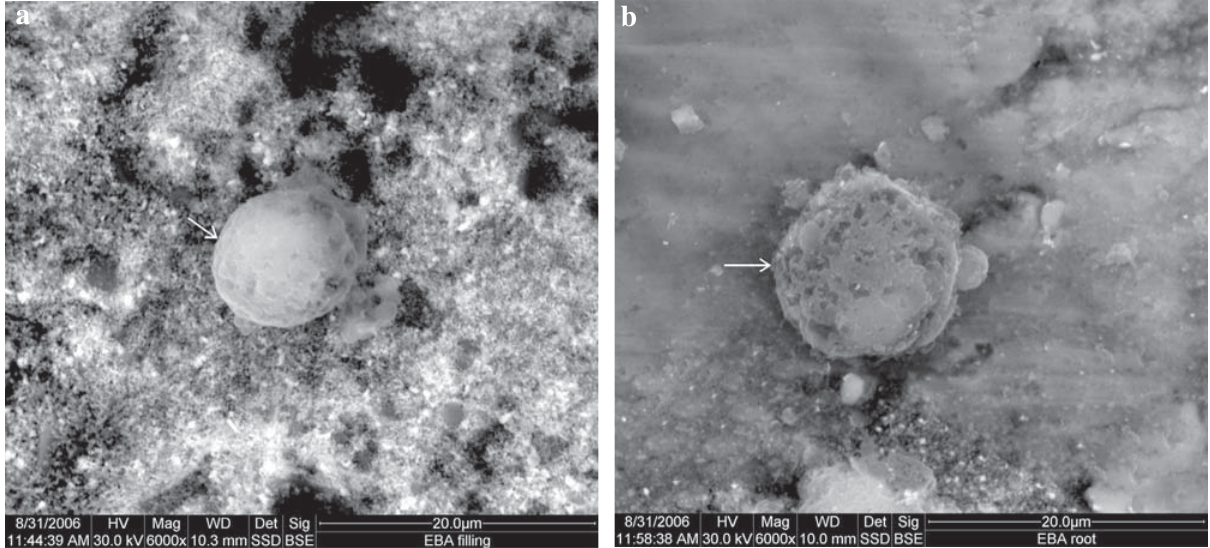
Figure 6 (cid:7)(cid:12)(cid:31)(cid:21)(cid:15)(cid:6)(cid:6)(cid:5)(cid:6)(cid:13)(cid:12)(cid:3)(cid:14)(cid:3)(cid:21)(cid:17)(cid:16)(cid:9)(cid:6)(cid:12)(cid:8)(cid:5)(cid:21)(cid:16)(cid:9)(cid:4)(cid:21)(cid:9)(cid:22)(cid:3)(cid:12)(cid:24)(cid:31)!"(cid:29)(cid:12)(cid:8)(cid:5)(cid:21)(cid:16)(cid:9)(cid:13)(cid:16)(cid:15)(cid:22)(cid:18)(cid:12)(cid:9)(cid:23)(cid:12)(cid:31)(cid:19)(cid:22)(cid:3)(cid:16)(cid:12)!?$%(cid:12)(cid:24)(cid:15)(cid:29)(cid:12)(cid:8)(cid:15)(cid:17)(cid:3)(cid:16)(cid:5)(cid:15)(cid:14)(cid:12)(cid:4)(cid:19)(cid:16)(cid:23)(cid:15)(cid:21)(cid:3)(cid:12)(cid:24)(cid:9)(cid:16)(cid:5)(cid:13)(cid:5)(cid:6)(cid:15)(cid:14)(cid:12)(cid:8)(cid:15)(cid:13)(cid:6)(cid:5)(cid:11)(cid:21)(cid:15)(cid:17)(cid:5)(cid:9)(cid:6)(cid:12) ’(cid:26)(cid:27)(cid:27)(cid:27)(cid:28)(cid:29)*(cid:12)(cid:24)/(cid:29)(cid:12)(cid:16)(cid:9)(cid:9)(cid:17)(cid:12)(cid:4)(cid:19)(cid:16)(cid:23)(cid:15)(cid:21)(cid:3)(cid:12)(cid:24)(cid:9)(cid:16)(cid:5)(cid:13)(cid:5)(cid:6)(cid:15)(cid:14)(cid:12)(cid:8)(cid:15)(cid:13)(cid:6)(cid:5)(cid:11)(cid:21)(cid:15)(cid:17)(cid:5)(cid:9)(cid:6)(cid:12)’(cid:26)(cid:27)(cid:27)(cid:27)(cid:28)(cid:29)(cid:30)(cid:12)$(cid:16)(cid:16)(cid:9);(cid:4)(cid:12)(cid:5)(cid:6)(cid:10)(cid:5)(cid:21)(cid:15)(cid:17)(cid:3)(cid:12)(cid:21)(cid:3)(cid:14)(cid:14)(cid:4)